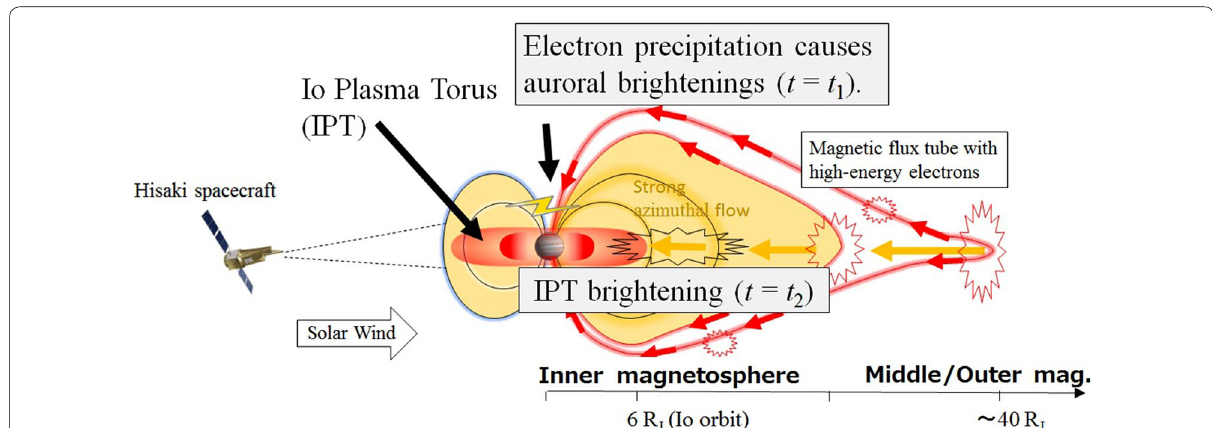
Fig. 1 Schematic view of the Jovian magnetosphere. The magnetosphere is the cavity in the solar wind (SW) created by the Jovian magnetic field and is stretched antisunward. The aurora is manifested by increasing energetic (energy of 100–300 keV) electron precipitation along the magnetic field line to Jupiter’s polar atmosphere from the middle/outer magnetosphere (time t 1 ). Inward transport of hot electrons (energy of 10–100 s = of electron volts, presumed to come from the middle magnetosphere together with energetic electrons) to the inner part of the magnetosphere causes torus brightening (time t 2 ). An issue addressed for years is the energy source that sustains the intense radiation of the IPT. The hot electron = transport from the distant region is one candidate. If the position of high-energy electron emergence in the middle/outer magnetosphere does not greatly change, the travel time ( t 2 t 1 ) represents the average inward velocity between the two −